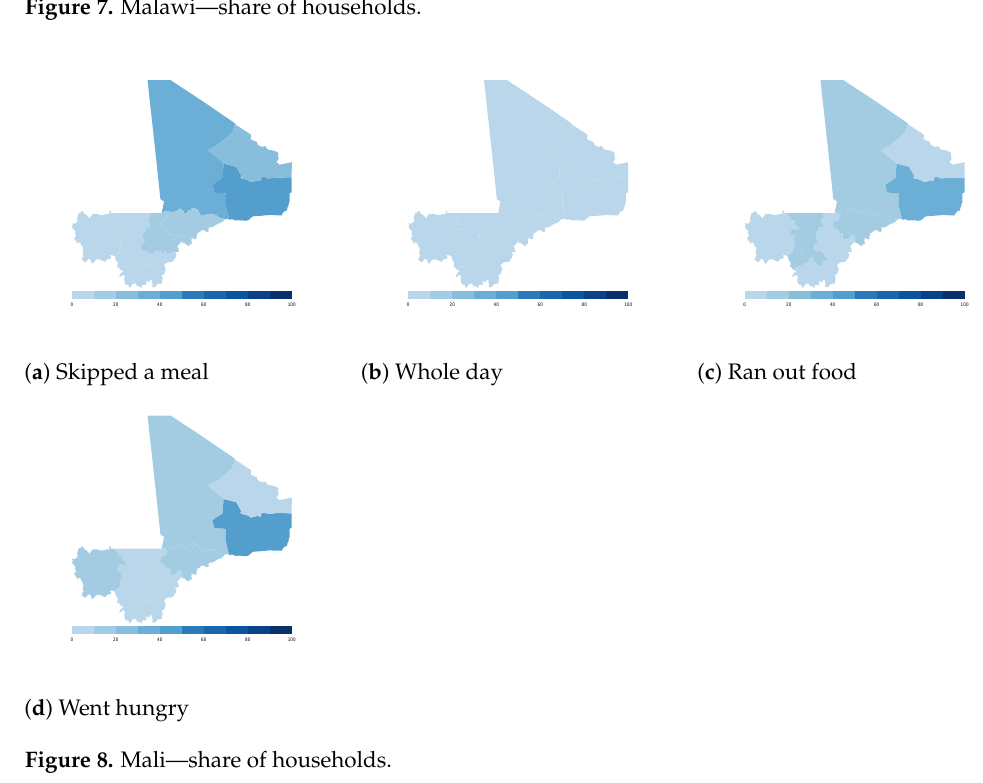
Figure 8. Mali—share of